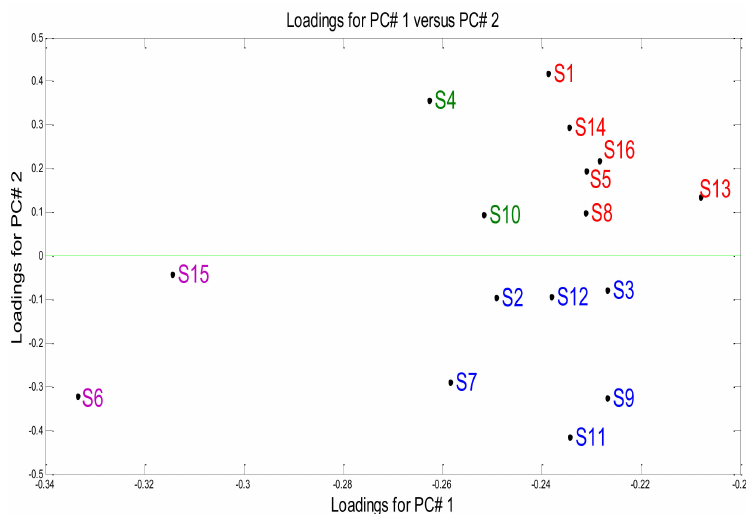
Figure 6. Loadings of bacteria: (Purple) Sterile water, (Red) E. coli , (Blue) Pseudomonas aeruginosa and (Green) Klebsiella oxytoca